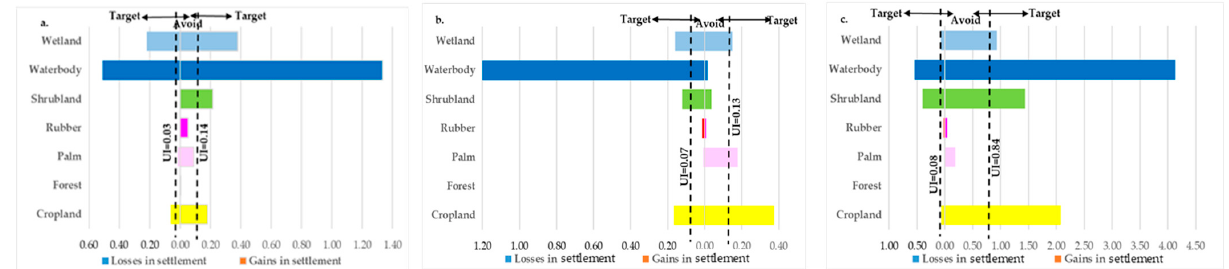
Figure 7. Transition level intensities for rubber for the period ( a ) 1986–2002, ( b ) 2002–2015 and ( c ) 2015–2020 (gains on the right, losses on the left).